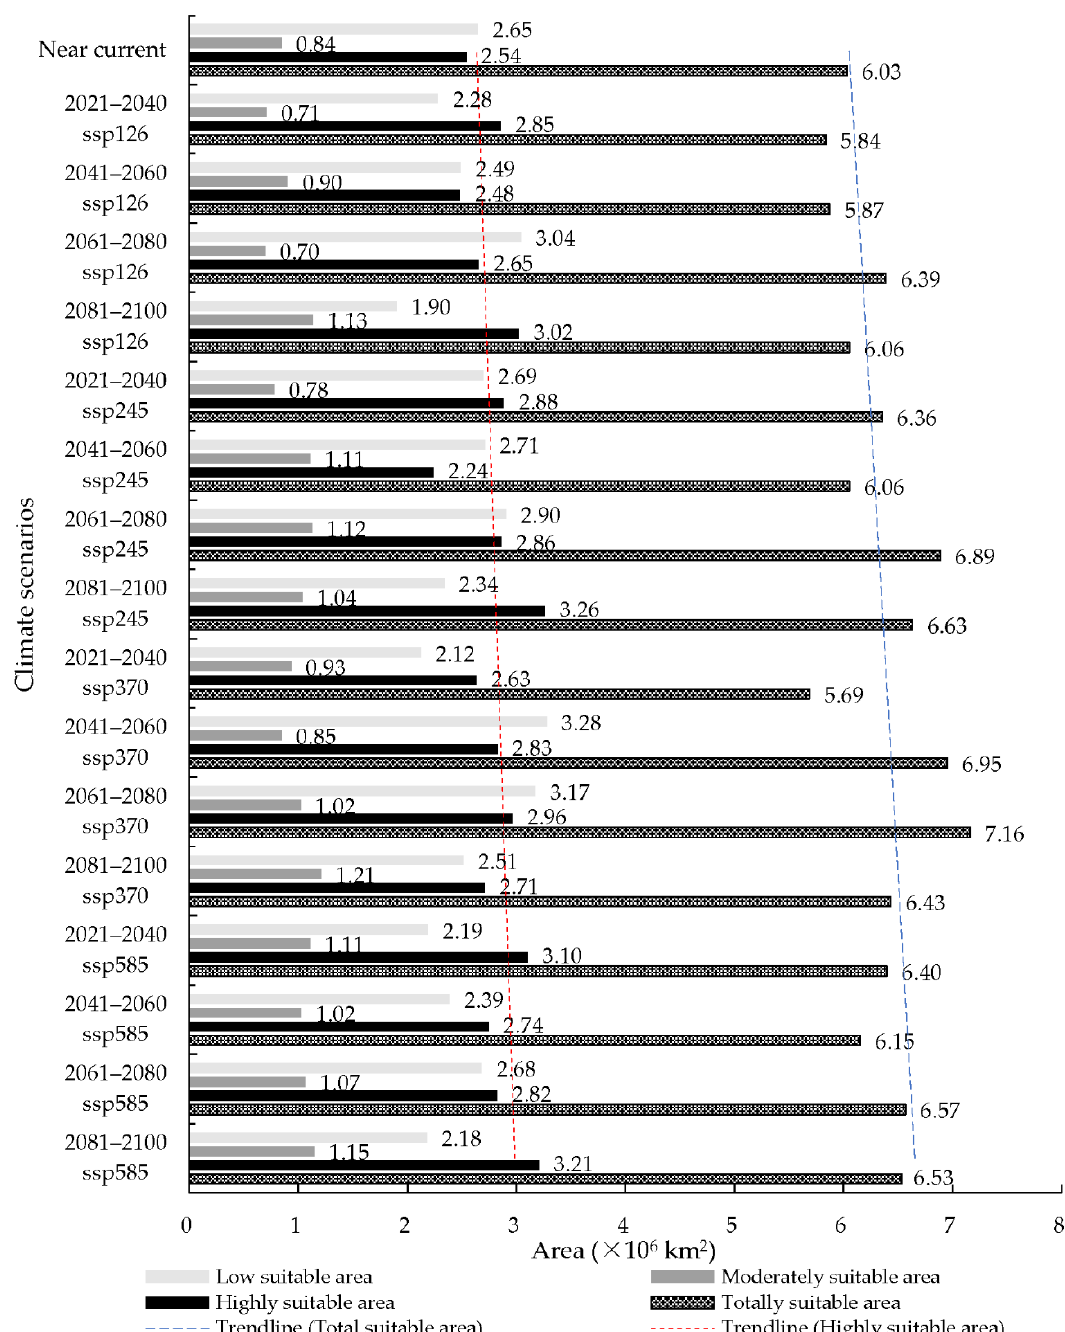
Figure 7. The area of suitable area of S. nitobei in China under the near current and future climate conditions.